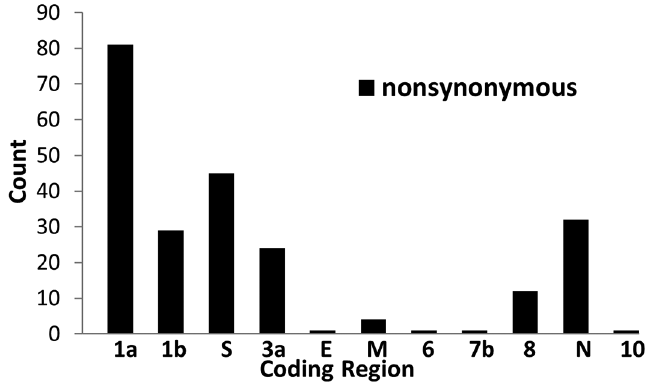
Figure 1. The numbers of nonsynonymous mutations in 11 coding sequences of SARS-CoV-2